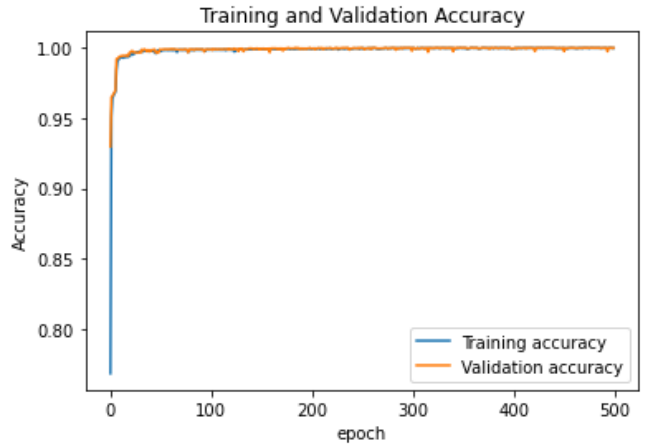
Figure 6. Training and validation accuracy with 500 epochs.